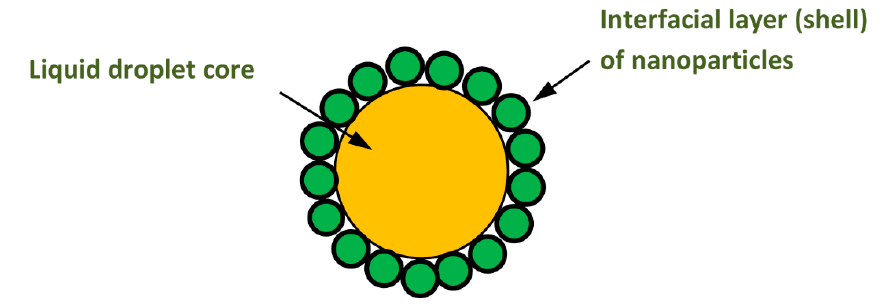
Figure 9. Core-shell Pickering emulsion droplet.